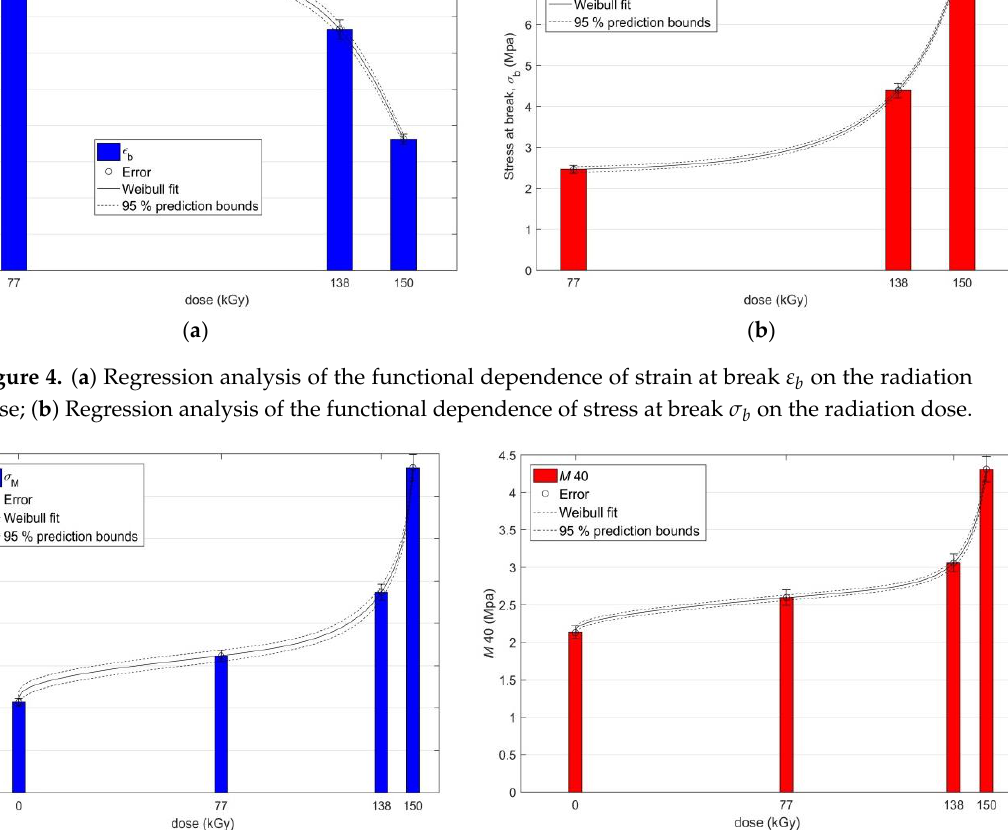
Figure 5. ( a ) Regression analysis of the functional dependence of the strength limit σ m on the radiation